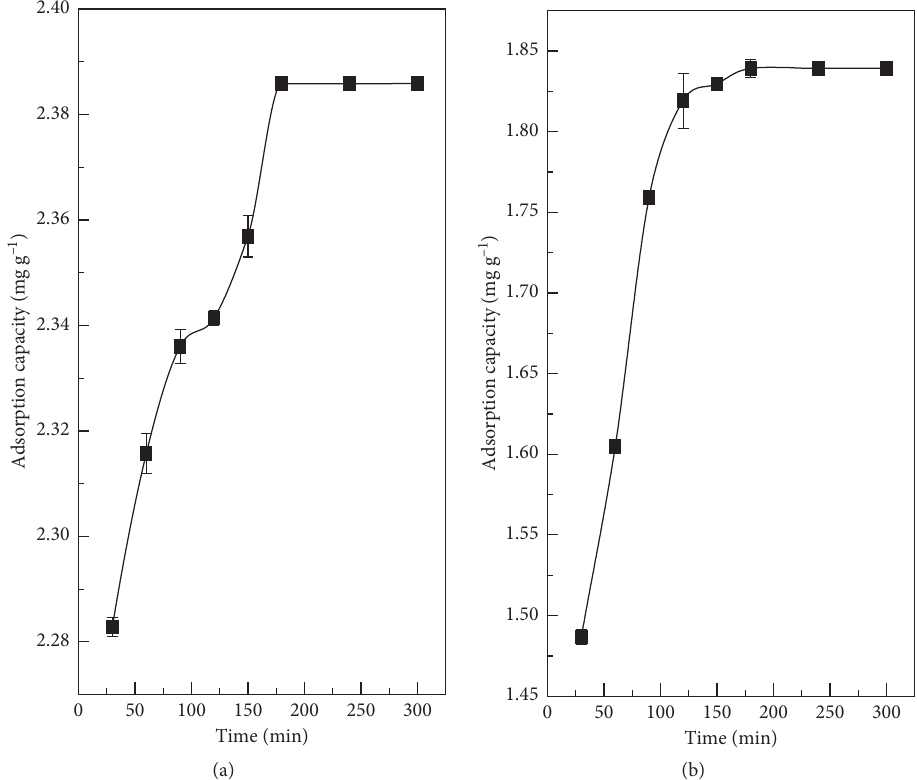
Figure 5: The effect of contact time on adsorption of wastewater (a) Cu (II) and (b) Cd (II) by SACL (experimental condition: Cu (II) concentration � 200mg · L − 1 ; Cd (II) concentration � 200mg · L − 1 ; amount of adsorbent � 4g; pH � 4; temperature � 25 ° C; and agitation speed � 150rpm) (error bars represent the standard deviation of three